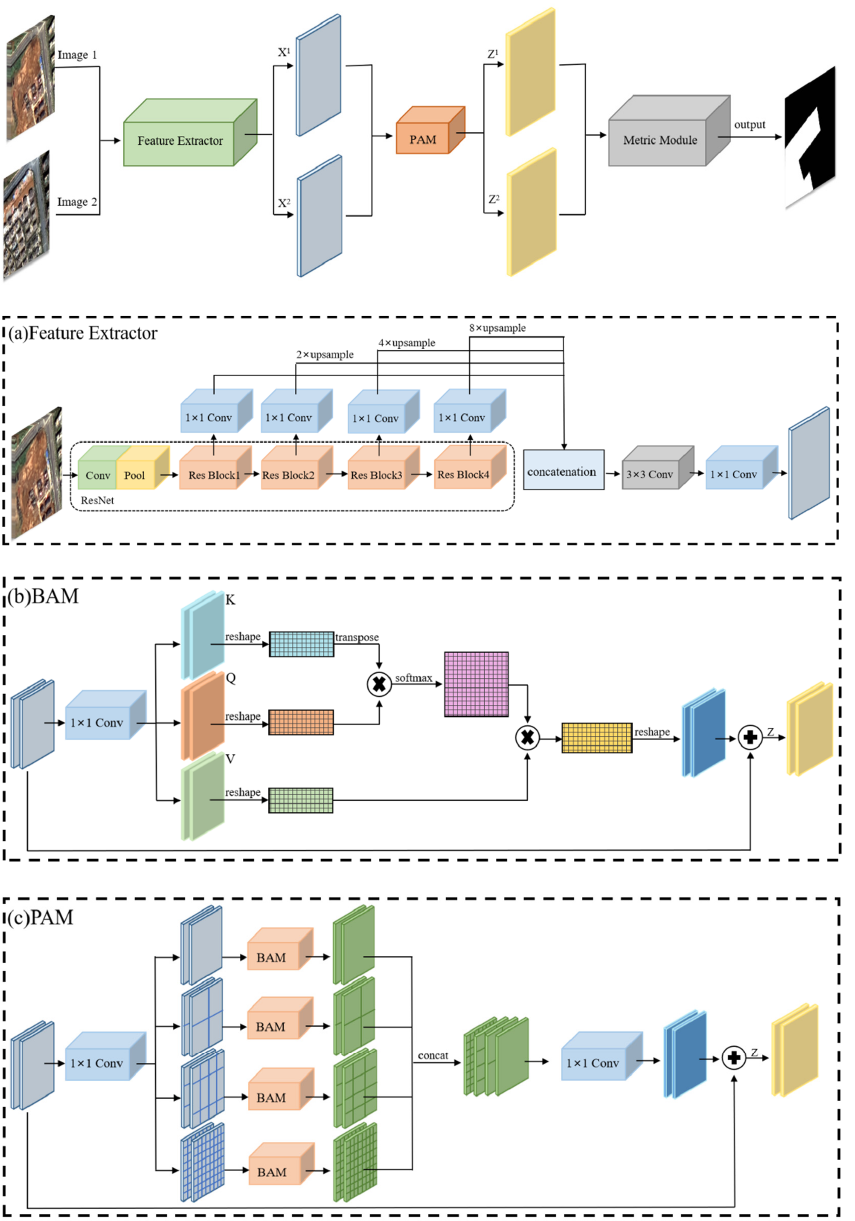
Figure 3. Illustration of STANet-PAM model. Our bi-temporal images turn into two feature maps after going through the Feature Extractor. Then the PAM self-attention module will update the two feature maps as two attention maps. Finally, the Metric Module generates an output using distance algorithms. ( a ) represents Feature Extractor, ( b ) represents BAM module, ( c ) represents PAM module.